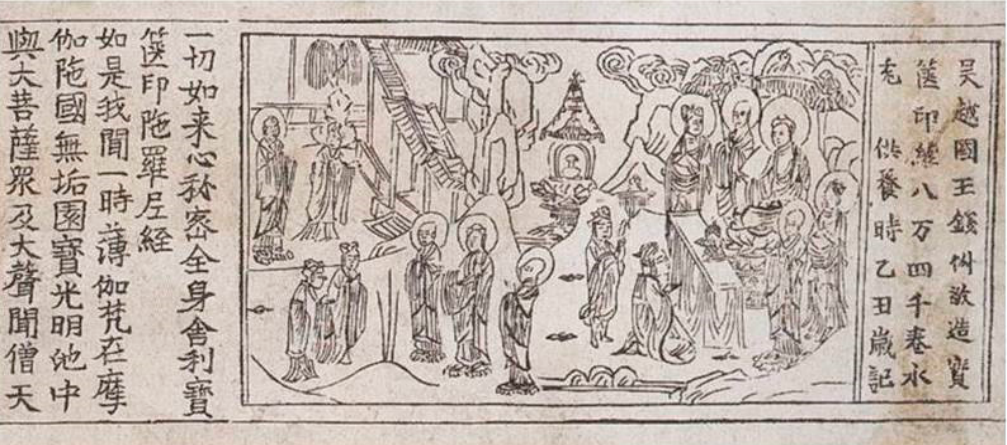
held a red wooden cylindrical container with a xylograph scroll of the Kara ṇḍ amudr ā S ū tra (Figure 3). 66